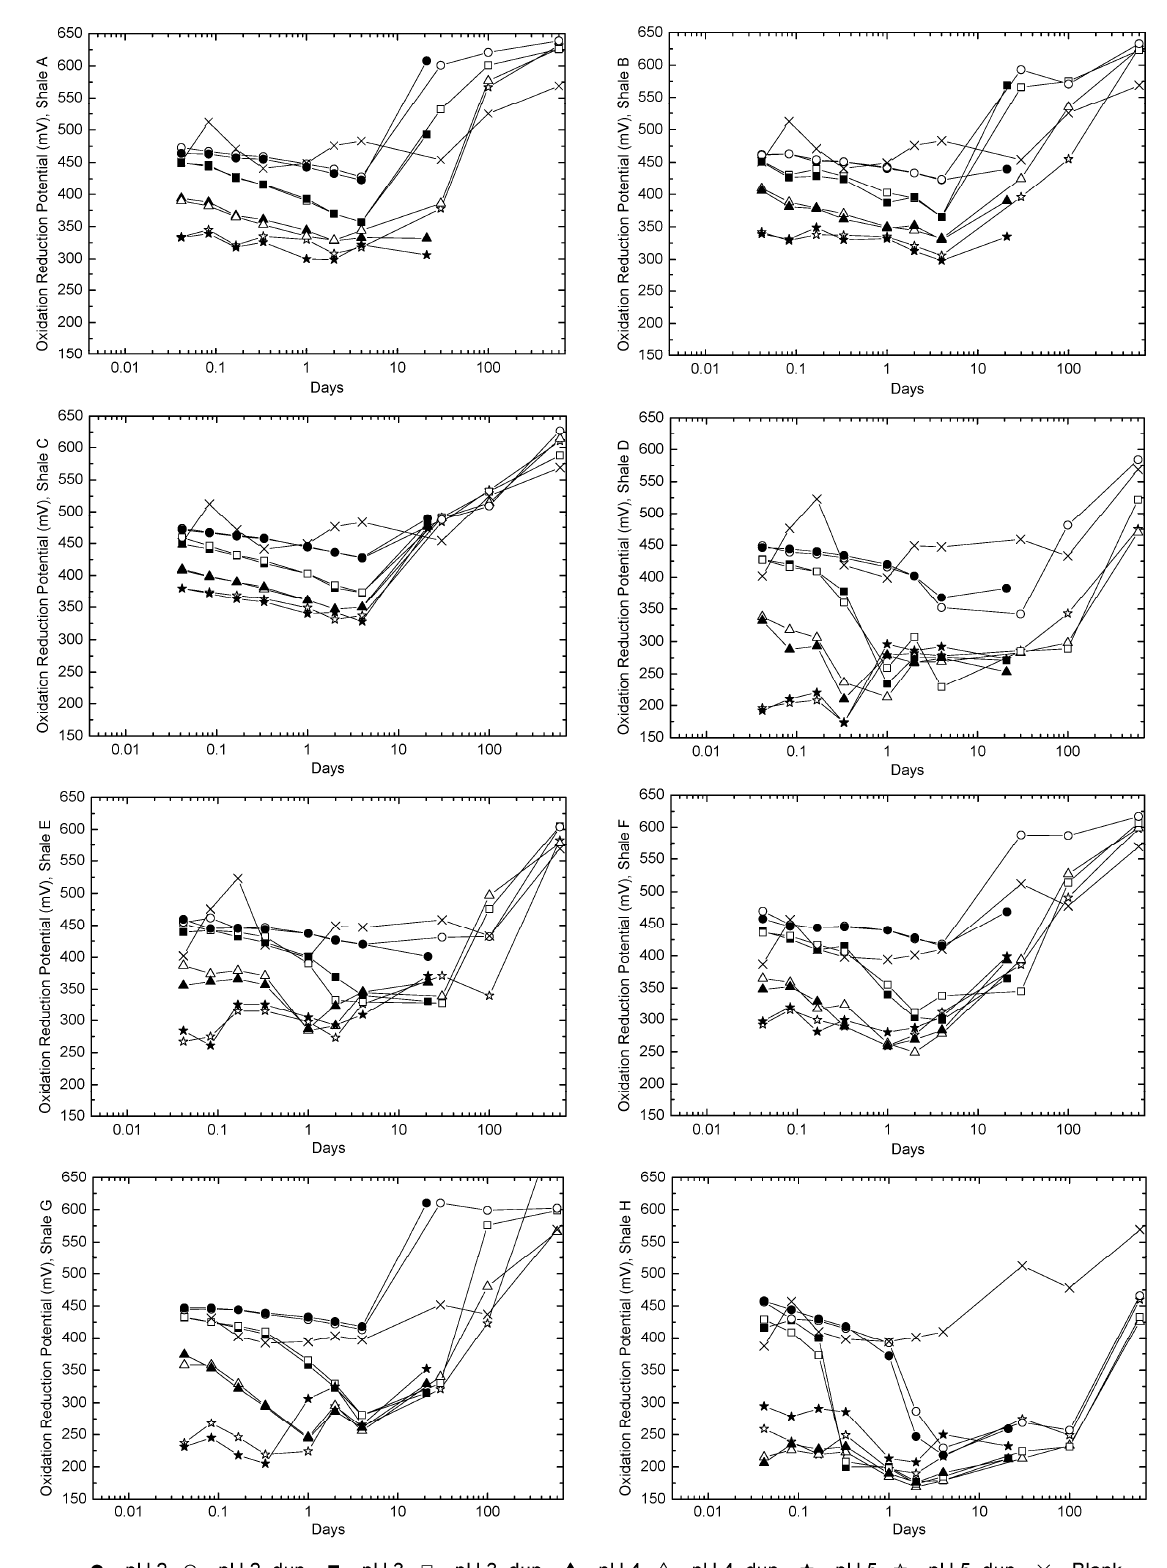
Figure 2. Oxidation reduction potential (ORP) recorded over time for all reaction vessels for all samples. Points on lines mark sample intervals from experiment commencement and 1, 2, 3, and 8 h, and 1, 2, 4, 21, 30, 100 and 600 days (logarithmic scale). The legend indicates initial sample